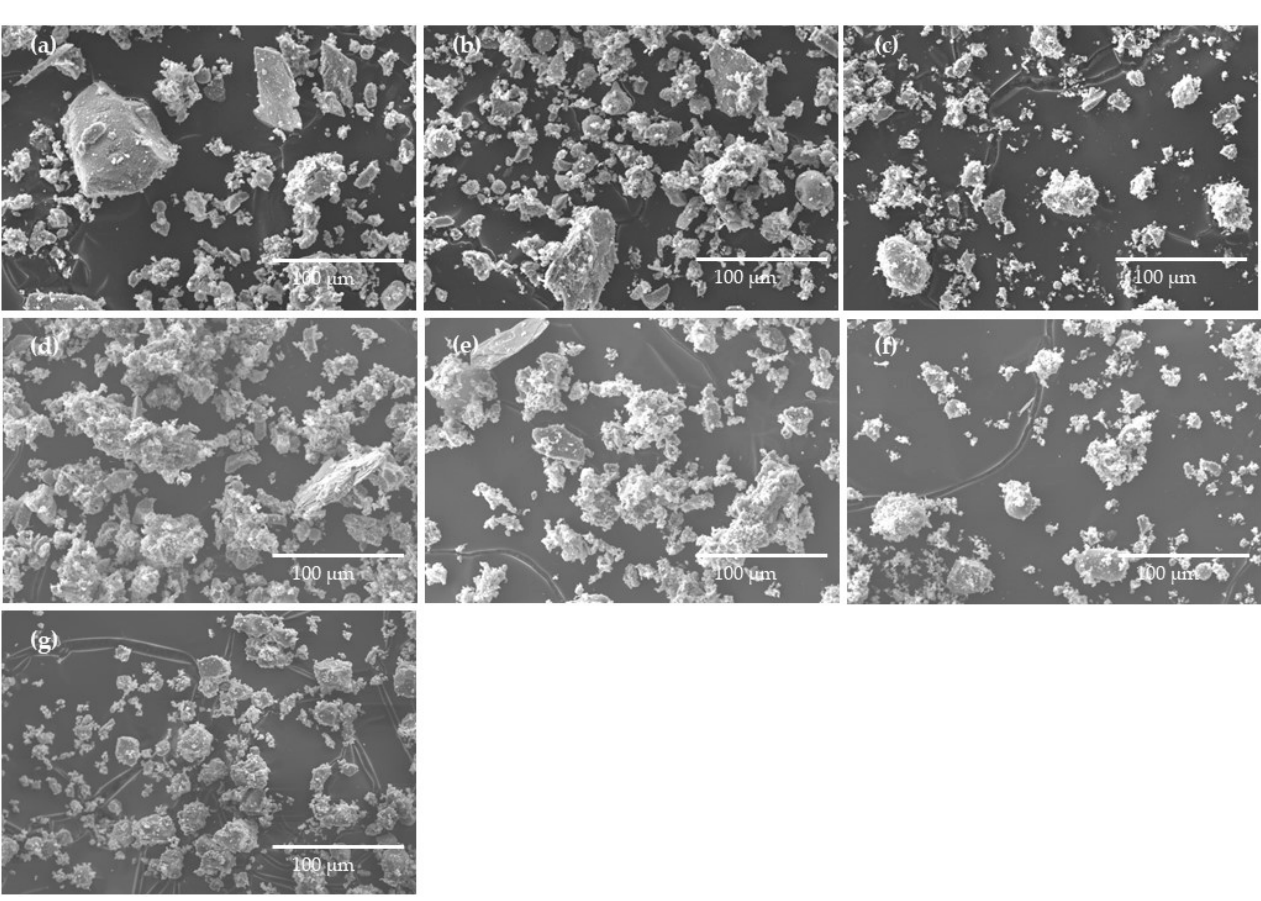
Figure 3. SEM micrographs of the waste samples: ( a ) BFA1, ( b ) BFA1_S, ( c ) BFA1_GS, ( d ) BFA2, ( e ) BFA2_S, ( f ) BFA2_GS, and ( g ) SG_GS.